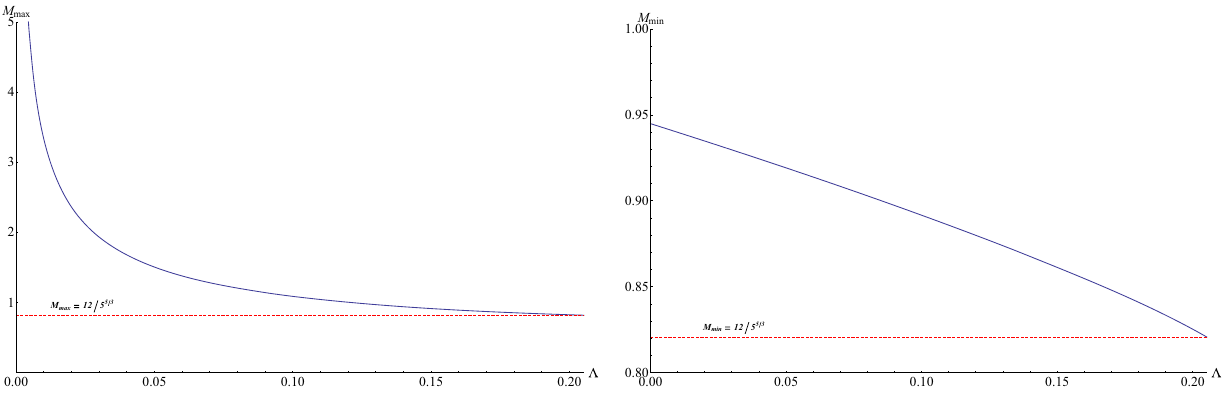
chemical potential (cid:12) , and the thermodynamic volume V .